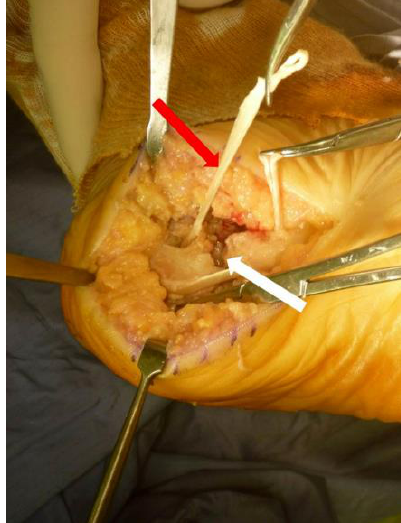
Figure 3. The ruptured fascia was reconstructed with allografting using the Pulvertaft weaving procedure. The white arrow indicates the gap between the two ends, and the red arrow indicates the allograft.